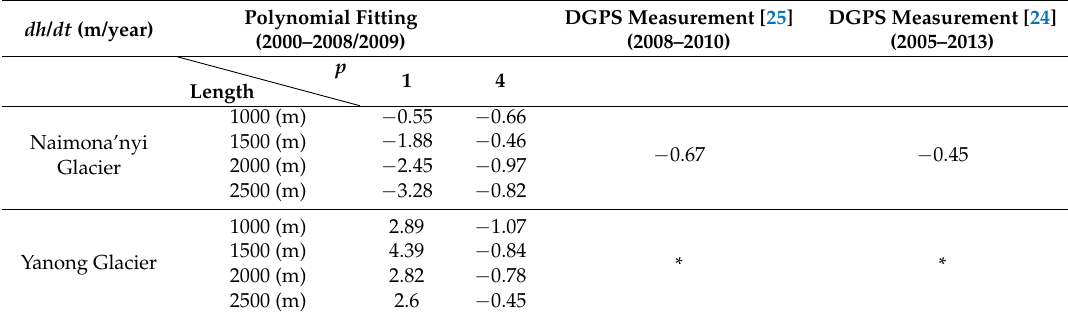
Table 3. Glacier elevation trends on Naimona’nyi glacier and Yanong glacier, respectively, with window lengths from 1000 m to 2500 m. Length: rectangle length along track.